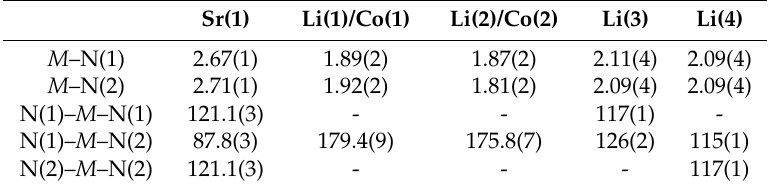
Table 3. Selected interatomic distances (Å) and angles ( ◦ ) for SrLi 2 {Li 0.65 Co 0.35 [Co 0.65 Li 0.35 N 2